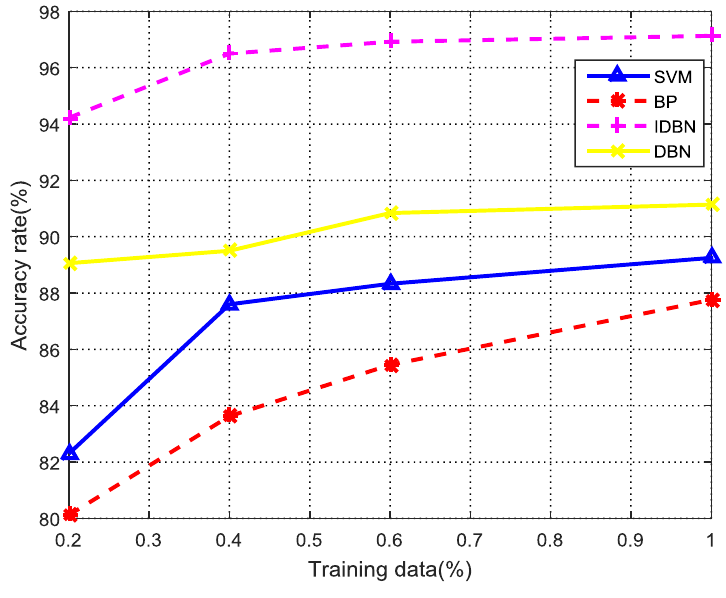
Figure 8. Accuracy rate with training data volume. Table 2. The time comparison of different classification simulation.